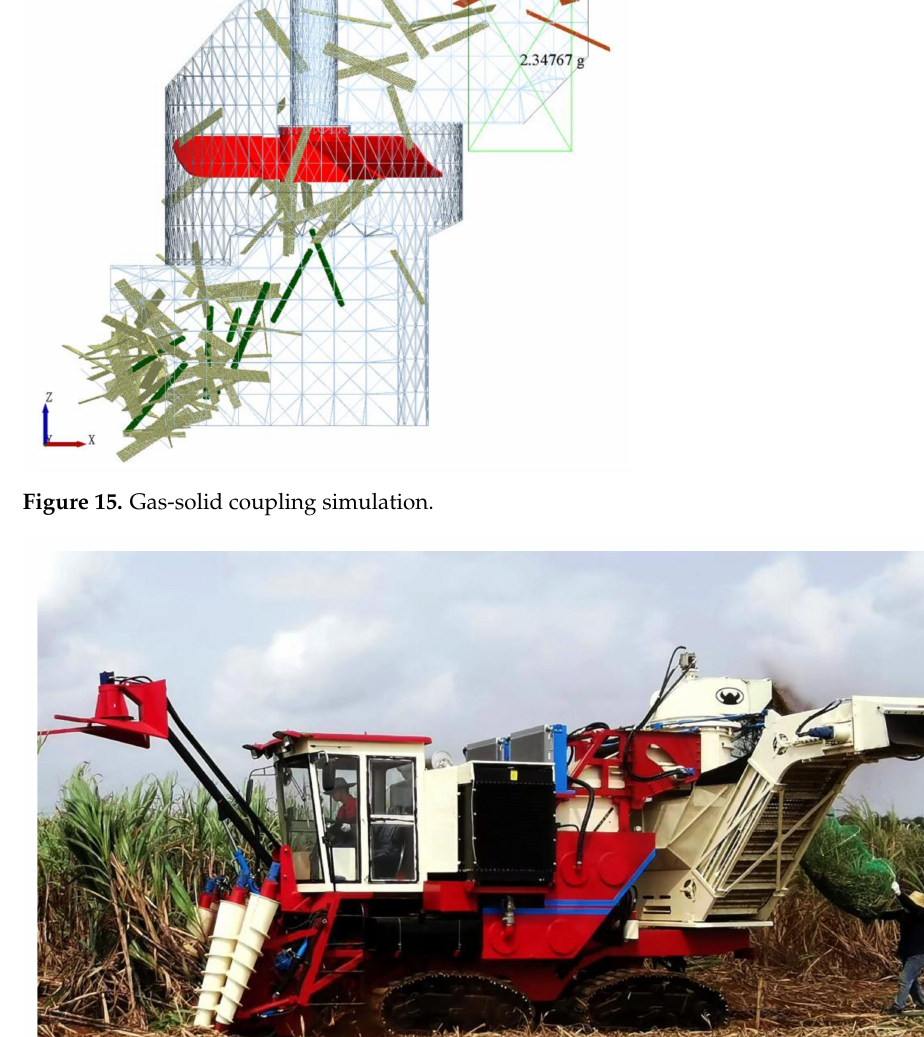
used for subsequent gas-solid coupling simulation